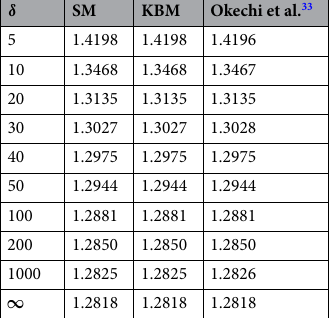
Table 1. Values of skin friction coefficient − C fs and comparison with Okechi et al. 33 for δ , when K 1 = 0, and M = 0 .